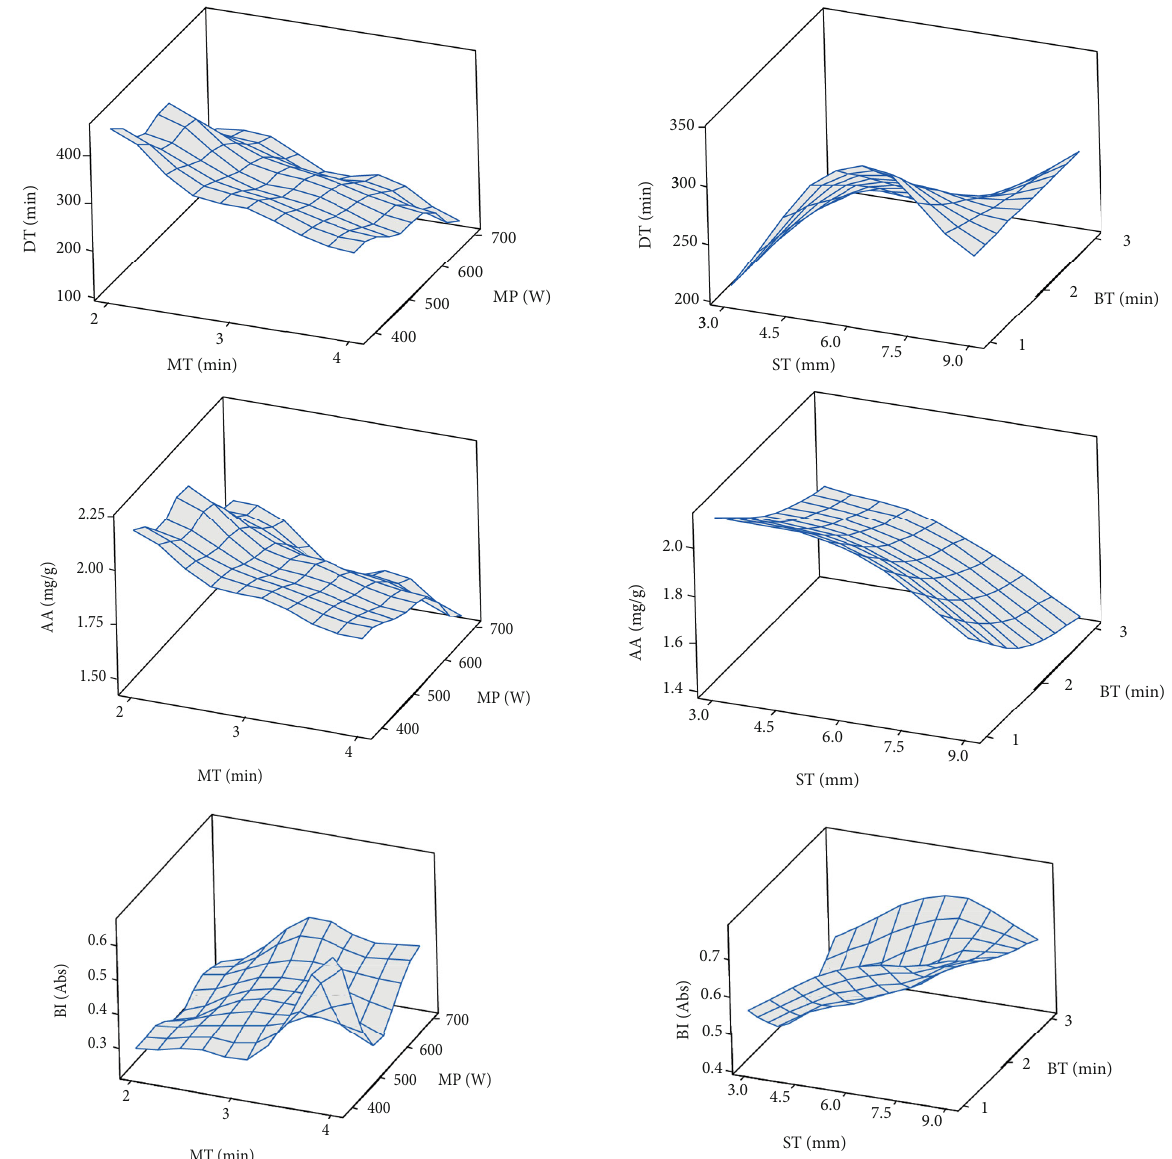
Figure 4: E ff ect of microwave and blanching pretreatments on drying time (DT), ascorbic acid content (AA), and browning index